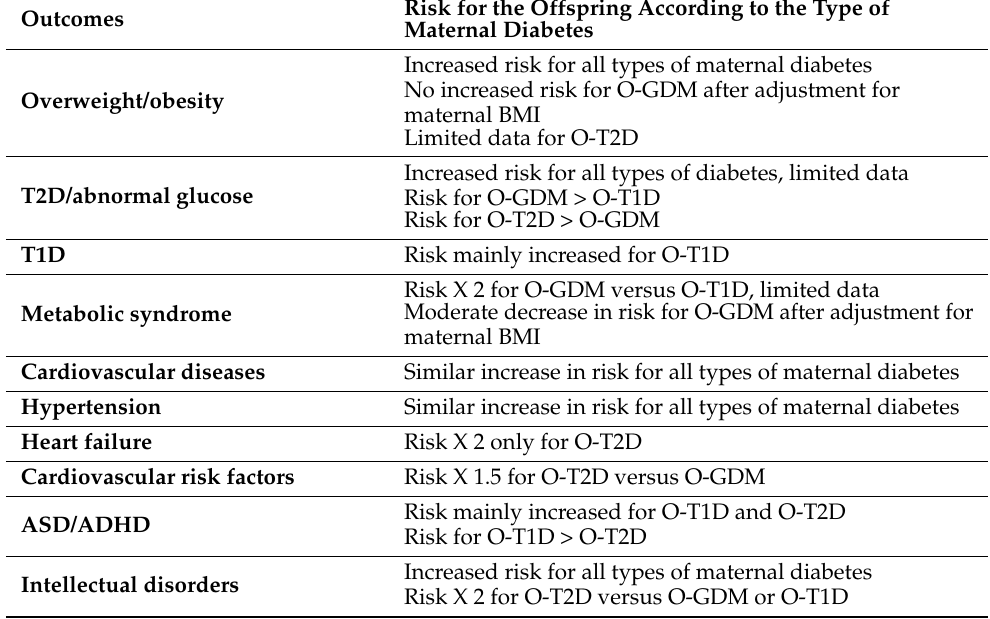
Table 6. Summary of the main